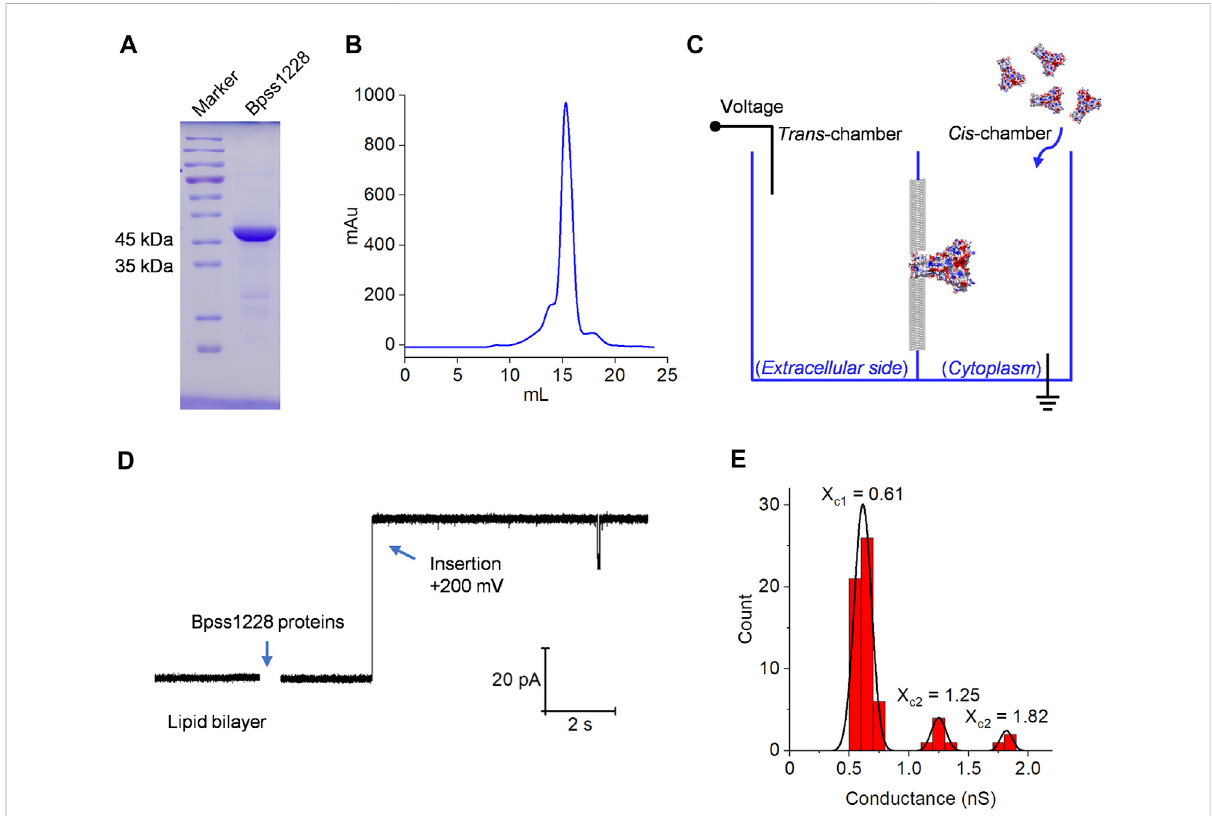
FIGURE 3 The Bpss1228 forms an ion channel in planar lipid bilayers. (A) 12% SDS-PAGE of Ni-resin puri fi ed Bpss1228, visualized with Coomassie brilliant blue,theMWofBpss1228is38.5 kDa. (B) Size-exclusionchromatographyanalysisoftheBpss1228.TheproteinswereanalyzedintheSuperose610/ 300 GLcolumn (GEHealthcare). (C) Theschematicillustration oflipid bilayerrecording. (D) The CorAinsertions inplanarlipidbilayersat200 mV. (E) Histogram oftheconductancevalues measuredfor theCorA( n =62). Theline represents aGaussian fi tto thebinneddata (binwidth =nS).The three peaks represent three different conductivity distributions. This experiment was conducted in 30/300 mM (trans/cis) NaCl, both buffered with 10 mM HEPES, pH